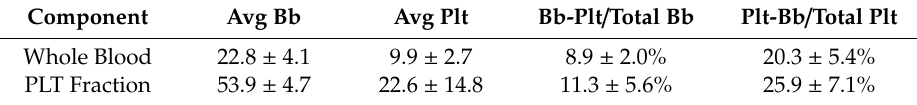
Table 1. Co-localization of Borrelia and platelets in experimentally infected whole blood and the platelet-enriched fraction obtained through centrifugation. Data collected as average counts per field of view with standard deviation from three biological replicates. Bb: B. burgdorferi ; Plt = platelet.